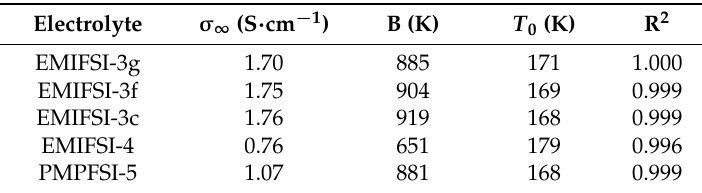
Table 4. Vogel–Fulcher parameters calculated from the variation of the conductivity of the electrolytes with temperature.